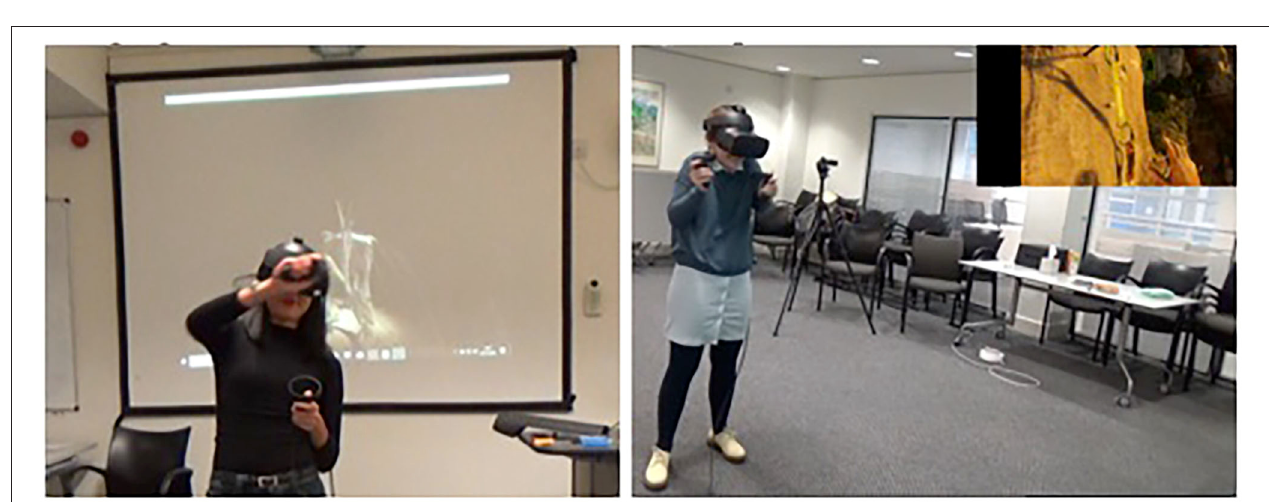
FIGURE 9 | Shielding face from dinosaur’s swinging tail; cringing on falling from rock face.